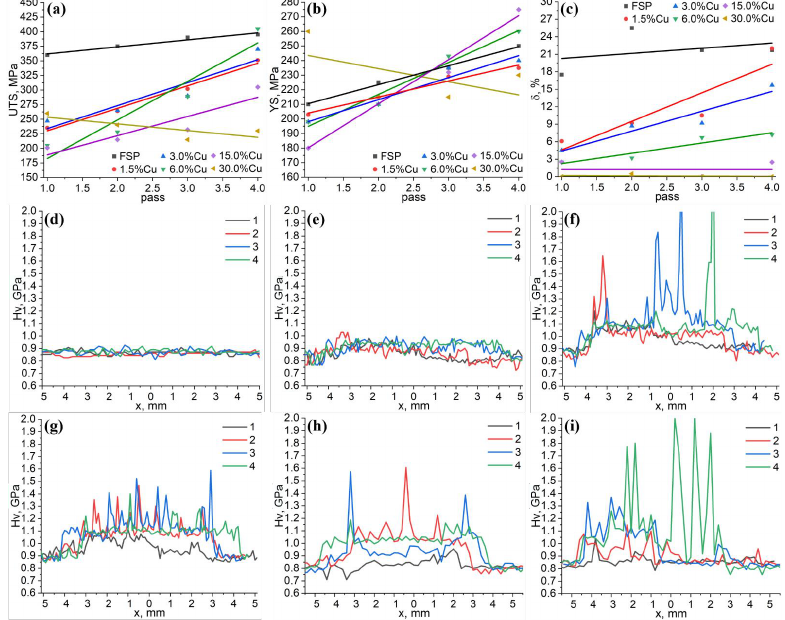
Figure 7. The ultimate tensile stress (UTS) ( a ), yield stress (YS) ( b ), strain-to-fracture (STF) ( c ) dependencies on pass number and copper content, microhardness profiles for AA5056 after FSP ( d ), 1.5%Cu ( e ), 3% ( f ), 6% ( g ), 15% ( h ) and 30% ( i ) copper samples. The YS value is maximum for the 4-pass FSP 15 vol.% and 6 vol.% Cu samples, i.e. higher than that of the AA5056 (Figure 7b) after the FSP, the corresponding STF values are maximum for all the pass numbers (Figure 7c). The STF values of composite samples increase with the pass number but always stay below those of FSPed AA5056. The maxi- mum STF value among all the composites was achieved on the 1.5 vol.% Cu sample after 4 passes. The most noticeable STF decrease occurred in samples with copper content from 3 to 30 vol.%.